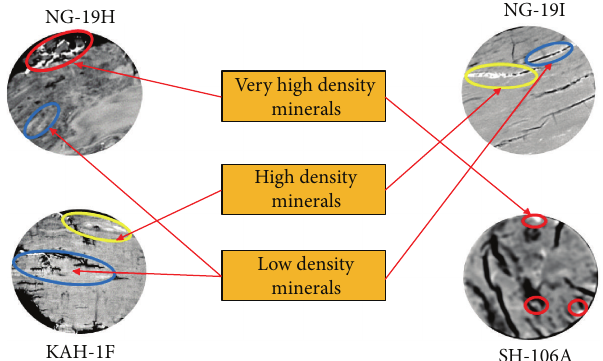
Figure 7: X-section slice images of cleat mineral and their infills as indicated by the X-ray CT technique of coal samples; very high density minerals (bright white, red oval), high density minerals (white, yellow oval), and low density minerals (grey, blue